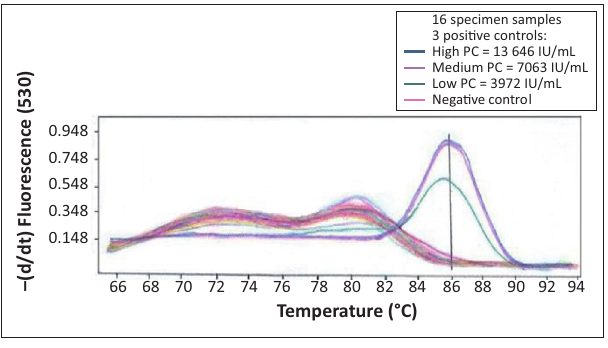
FIGURE 1: Melting curves at a melting temperature of 86 °C represent HCV-positive controls. Sixteen specimens that tested negative for HCV by serology were used as HCV-negative controls.